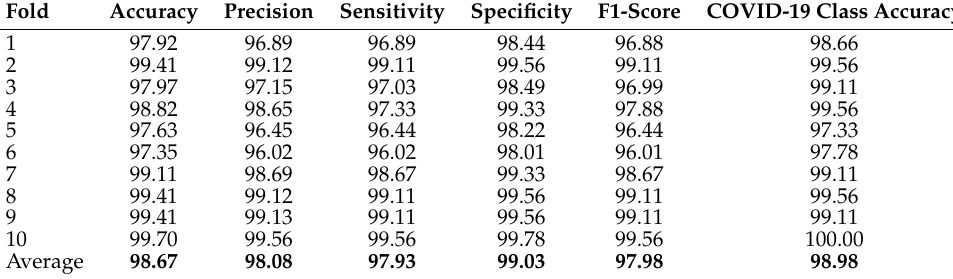
Table 5. Fold-wise multi-class classification performance (in %) on